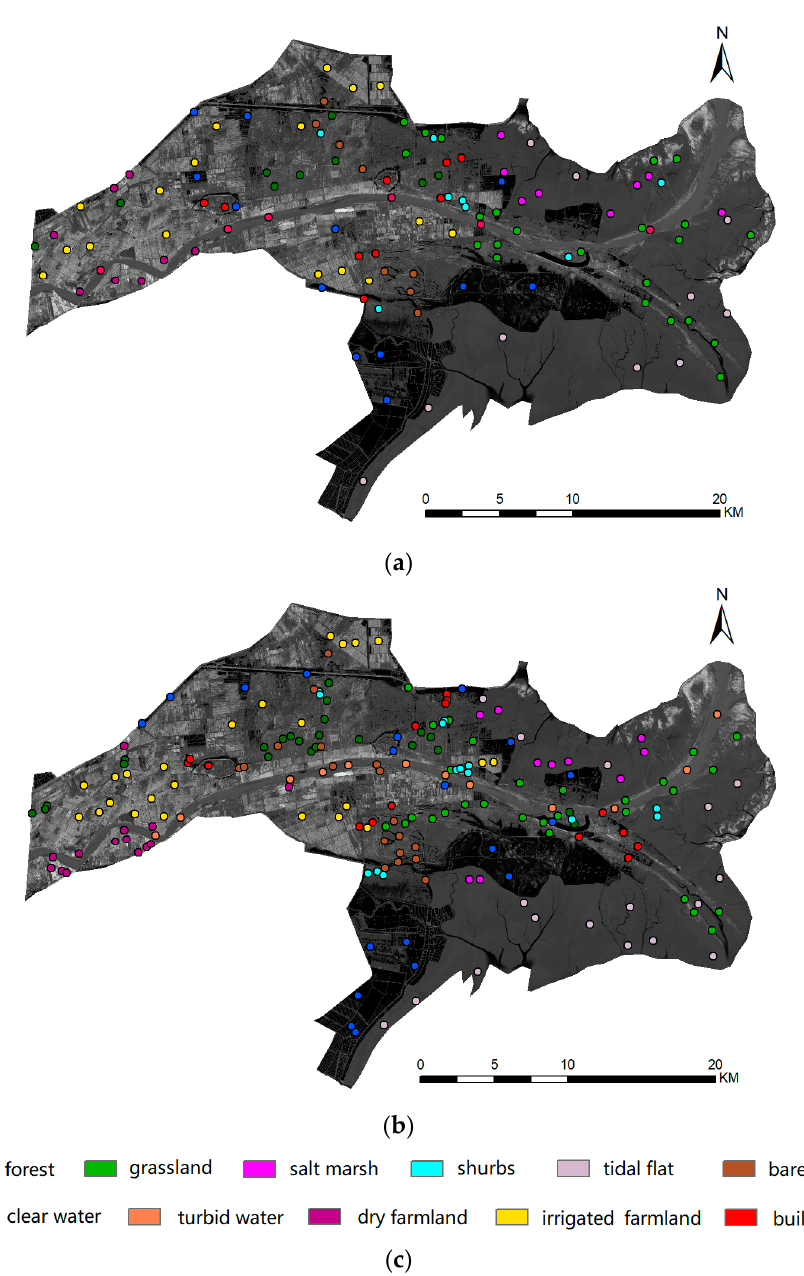
Figure 2. Spatial distribution of ( a ) Training samples; ( b ) Testing samples; and ( c ) Legend.